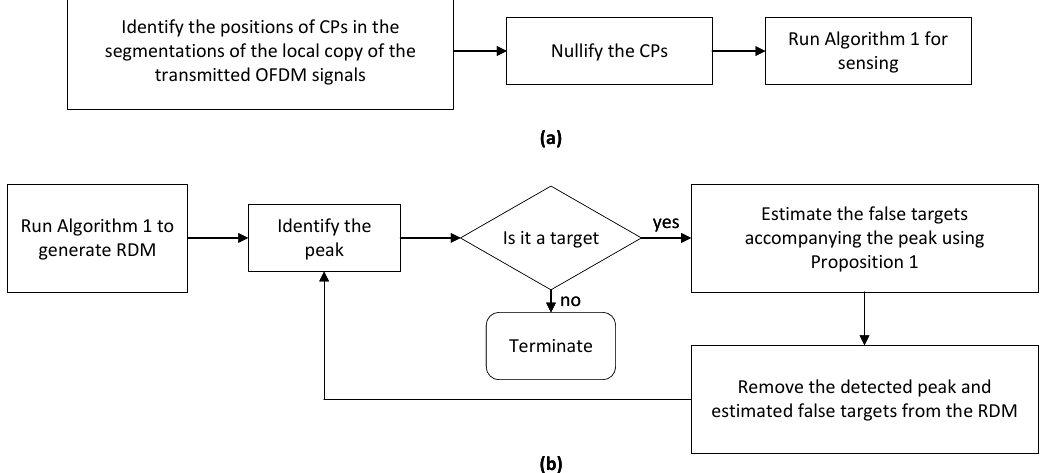
Figure 3. ( a ) The block diagram for the solution developed in Section 5.1; ( b ) the block diagram for the method designed in Section